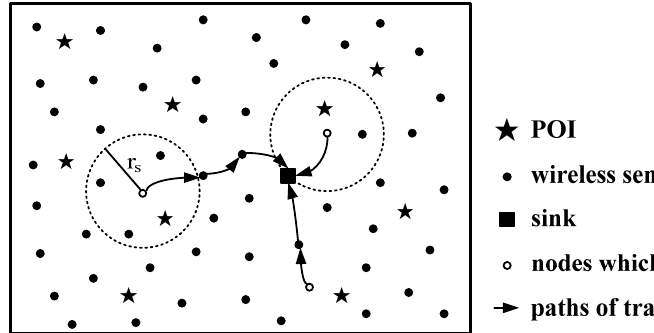
Figure 1. For the coverage-preserving application for a WSN, the events at the position marked by stars will be detected and reported to the sink node through the surrounding